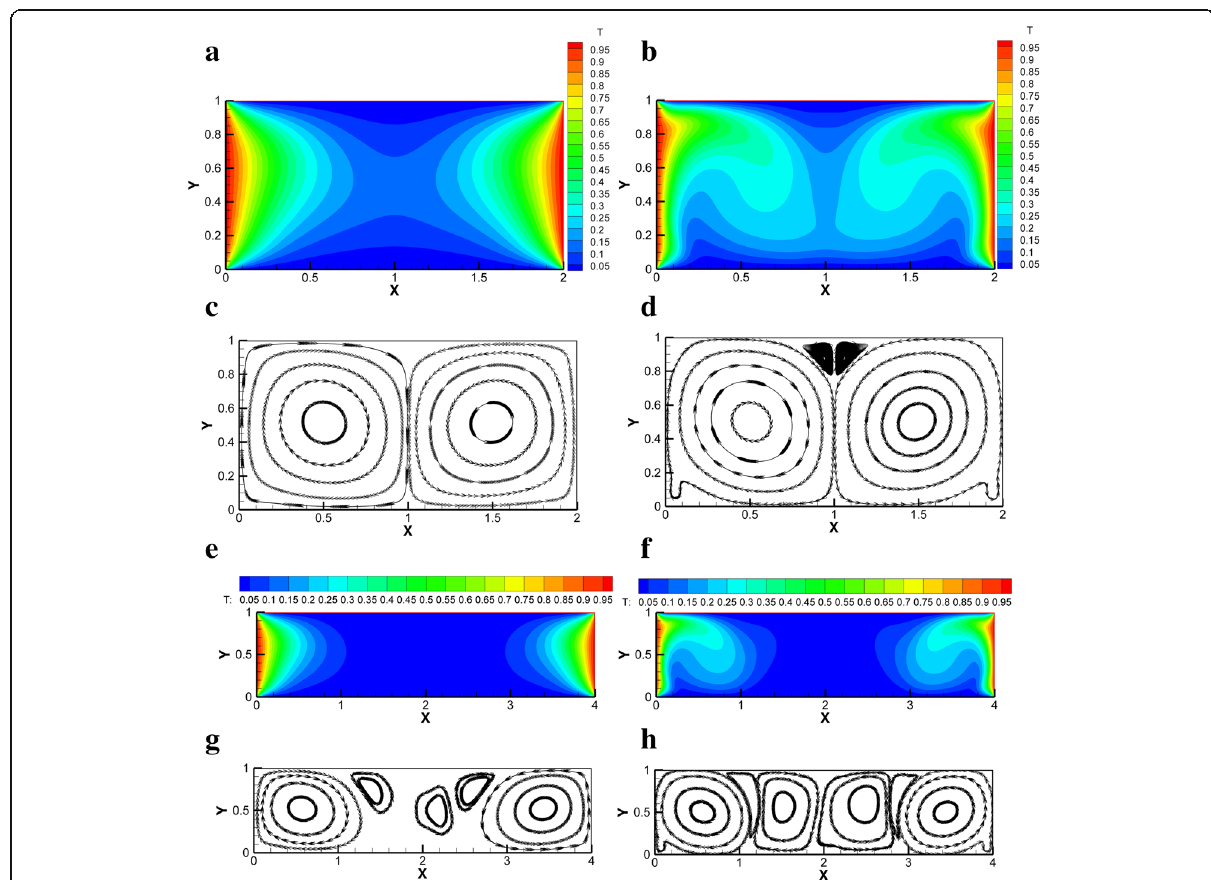
Fig. 2 Temperature nephogram and streamlines of Ag-Ga nanofluid. Temperature nephogram and streamlines of Ag-Ga nanofluid ( r =20 nm, φ =0.01) in the horizontal rectangular enclosure ( A =2:1 and A =4:1). Temperature nephogram: a Ra =1×10 3 , A =2:1. b Ra =1×10 5 , A =2:1. e Ra =1×10 3 , A =4:1.